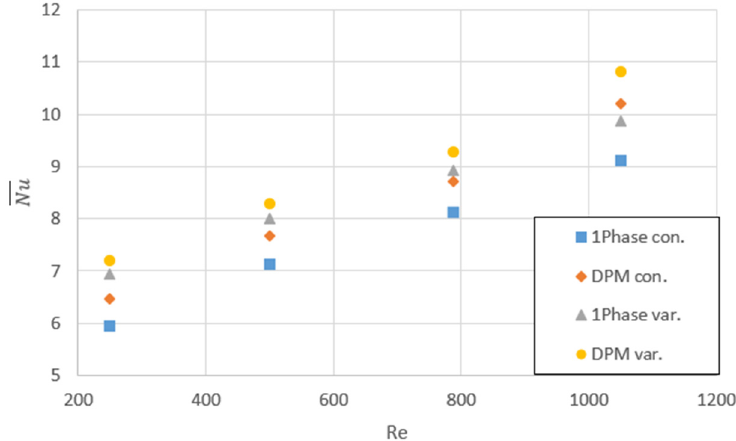
Figure 1. 𝑁𝑢(cid:3364)(cid:3364)(cid:3364)(cid:3364) ‐ Re relationship for water– γ Al 2 O 3 (1%) nanofluid—data source [18]. Figure 1. Nu-Re relationship for water– γ Al 2 O 3 (1%) nanofluid—data source